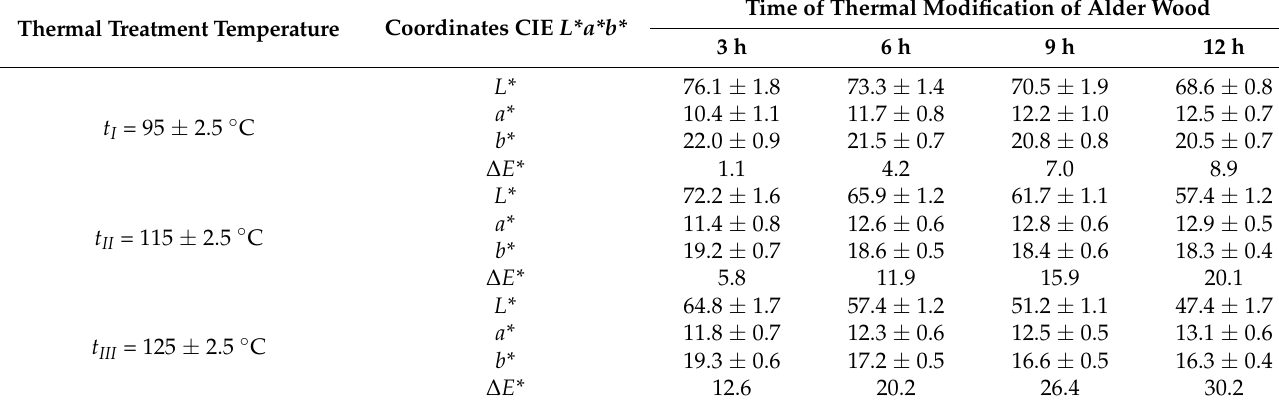
Table 6. Measured color values on the coordinates L*, a*, b* in the CIE color space L* a* b*, as well as the values of the total color difference ∆ E* of alder wood during the process of thermal modification of wood color. Thermal Treatment